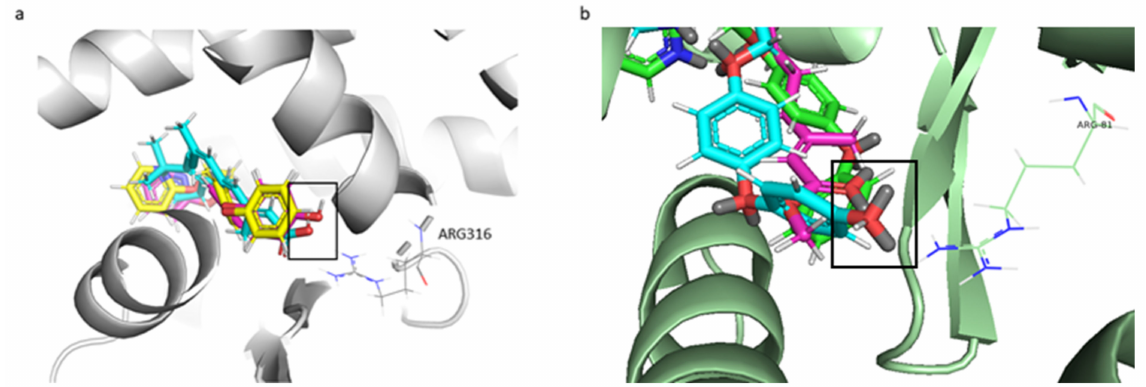
Figure 4. Ligand-receptor interactions. ( a ) The human hydrogen bond formed between the oxygen of 9-cis-RA (cyan) and 4 (cid:48) -OH-PPF (magenta) and Arg316. The box highlights the oxygen present in 9-cis-RA and the 4 (cid:48) -OH-PPF, but not in the pyriproxyfen (yellow). ( b ) The bee hydrogen bond formed between the oxygens of the juvenile hormone (cyan) and 4 (cid:48) -OH-PPF (magenta) and Arg81. The box highlights the oxygen present in the juvenile hormone and 4 (cid:48) -OH-PPF. The pyriproxyfen (green) does not have the oxygen for the hydrogen